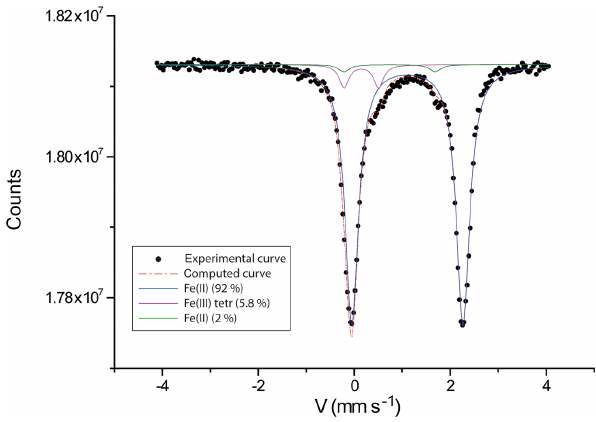
Figure 3. Deconvoluted Mössbauer spectrum of laurentthomasite.